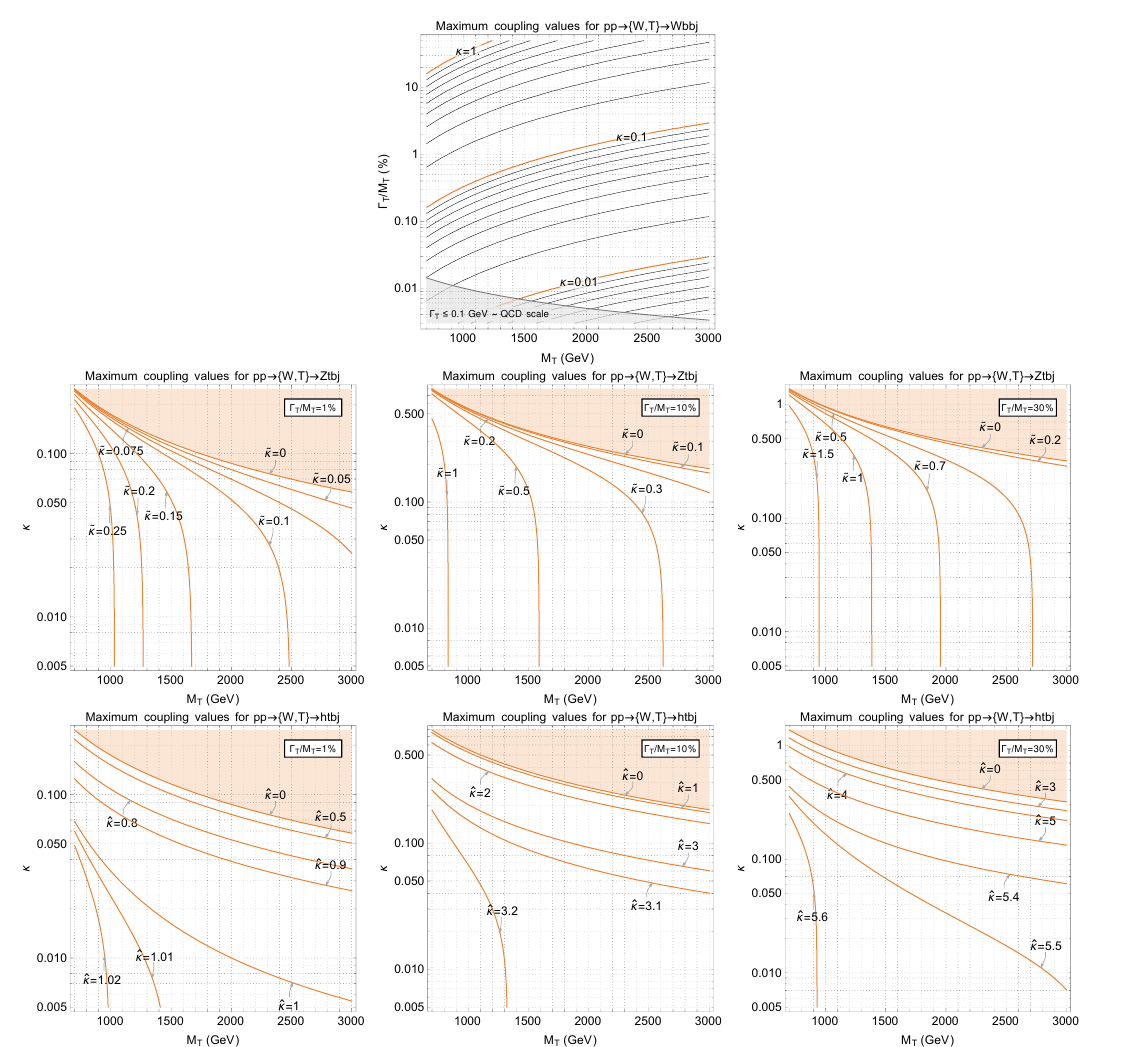
Figure 8 . Maximum values of the couplings which saturate the values of the total width of the T VLQ for the pp → Wbbj (top), Ztbj (centre) and Htbj (bottom) processes and for different values of the Γ ratio for the Ztbj and Htbj processes. The couplings κ , ˜ κ , ˆ κ refer respectively to T /M T the coupling of Wb , Zt and ht with the VLQ T . As the partial widths depend on the couplings squared, the limits above apply to the absolute values of the